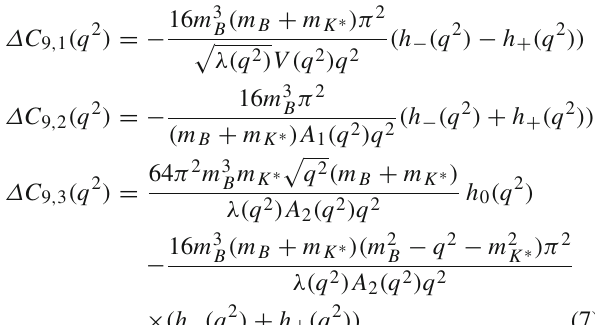
Table 1 68% and 95% HPDI of the posterior distribution of the ( i ) hadronic parameters h λ . The bold highlights ranges not including 0. ( 0 ) ( 2 ) Genuine hadronic effects encoded in h and h − are found to be non- 0